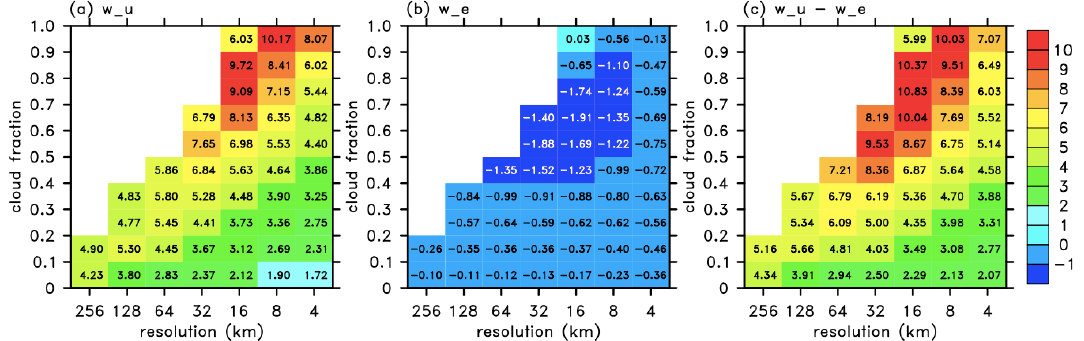
Figure 4. Vertical velocity in ( a ) updrafts, ( b ) environment, and ( c ) their difference as functions of cloud fraction and subdomain size at the 500 hPa height.